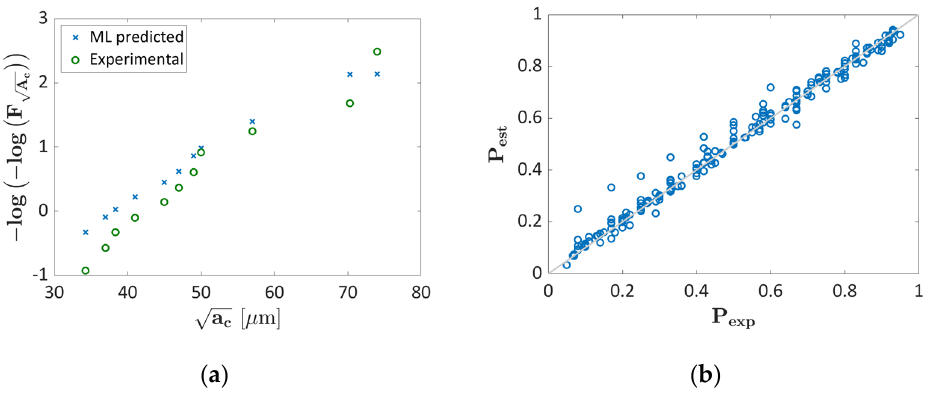
( b ) Figure 7. Gumbel plot for k = 1; ( a ) validation dataset; ( b ) training data. According to Figure 7a, the predicted probabilities are not conservative, with the Probability ML algorithm providing larger probabilities and with the predicted data above the experimental data. Indeed, the ML-predicted probability of a defect smaller than (cid:3493)𝑎 (cid:3030) is larger (with therefore a smaller probability of defects with a size larger than (cid:3493)𝑎 (cid:3030) ), being theML predictions less-safe. The percent error, i.e., the difference between the predicted probability and the experimental one, normalized by the experimental prob- ability has also been adopted to quantify the error in the prediction. The percentage error has been found in the range [5.2, 1310]%, with a median value of 94%. As expected, the percentage error is very large, especially for small defect sizes where it reaches its maxi- mum. Indeed, the difference range reduces to [5.2, 605]%, with the median value equal to